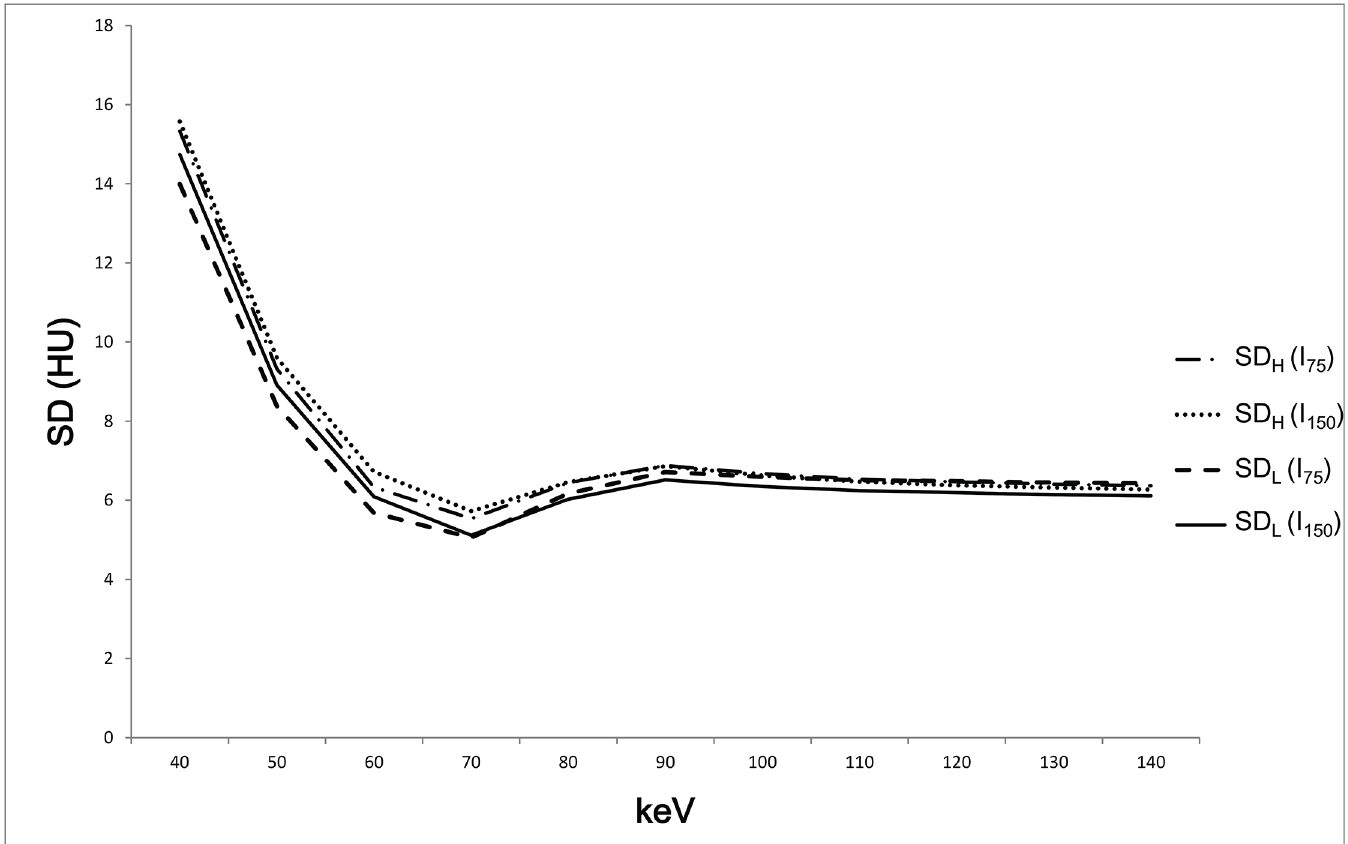
Fig 3. The SD showed its lowest value in 70 keV in both the AP and HVP for all concentrations of